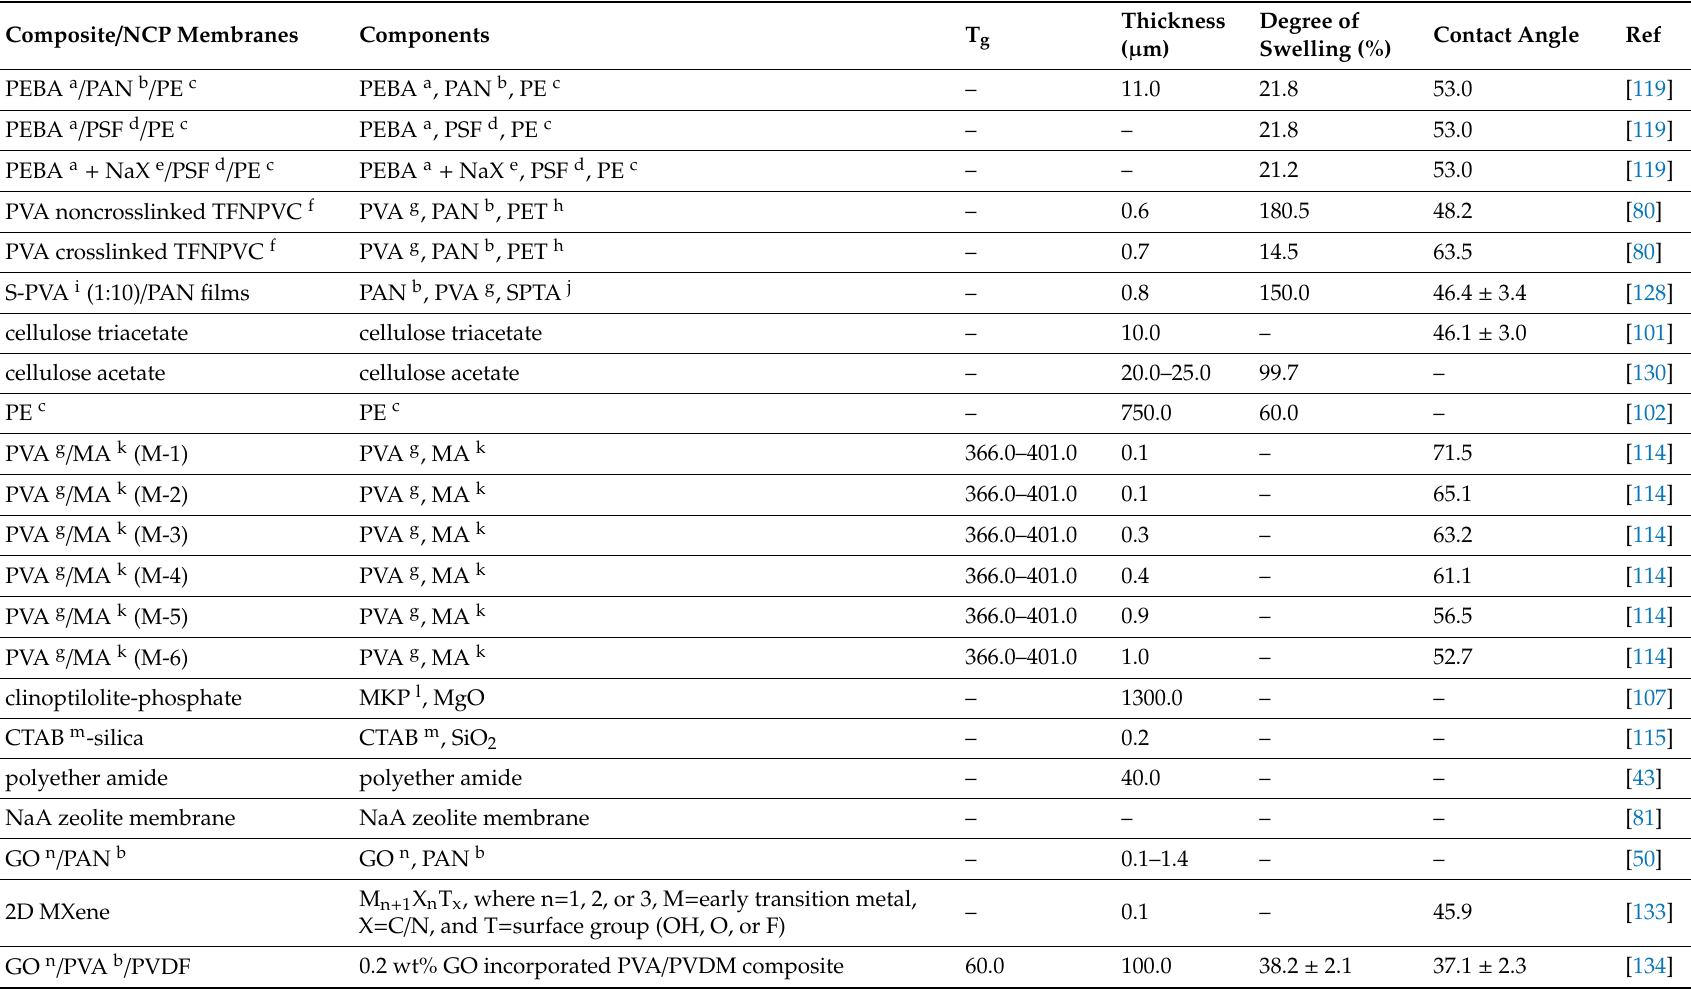
Table 2. Properties of polymeric membranes and their performances in pervaporative